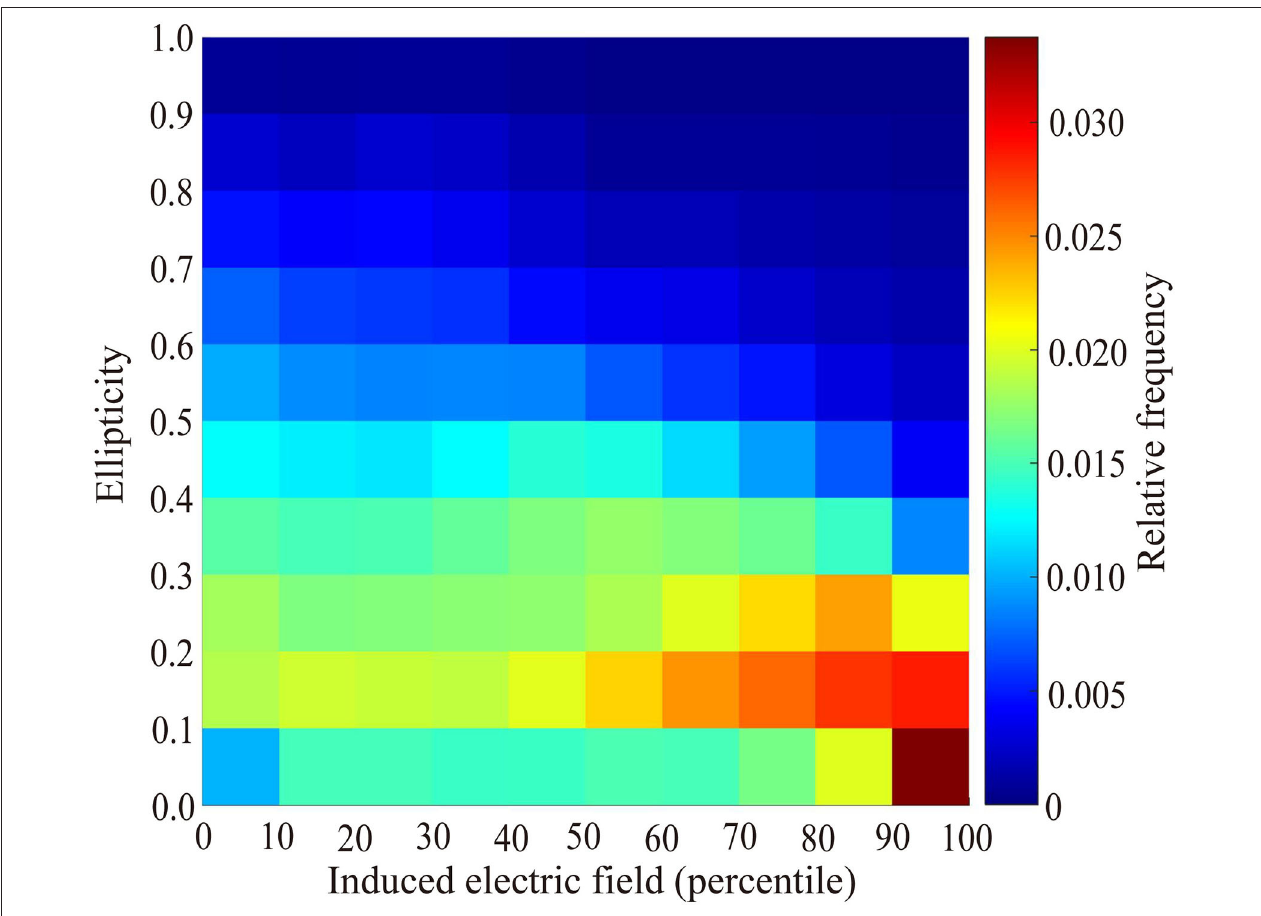
FIGURE 9 | Distribution of relative frequency of voxels in the human model as a function of induced electric field and ellipticity in decile